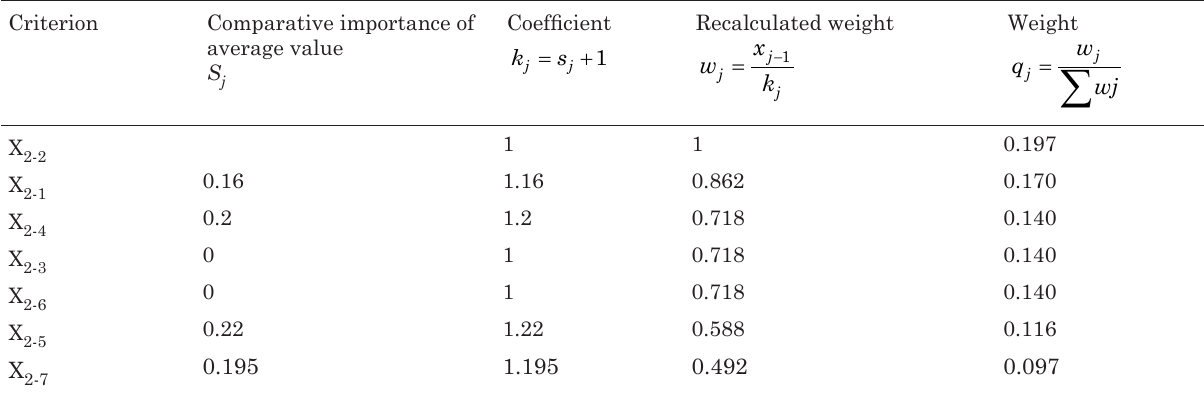
Table 6. Final results of SWARA method in weighting criteria of environment Criterion